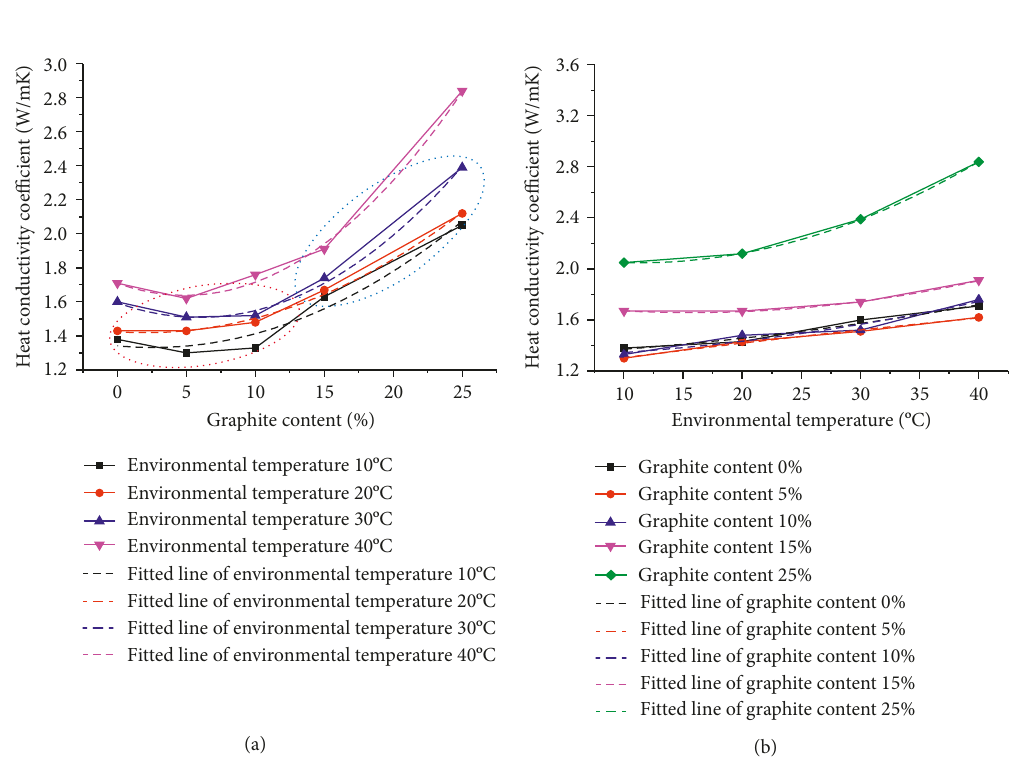
Figure 7: Heat conductivity coefficients of tested graphite concretes. (a) Different graphite contents. (b) Different environmental